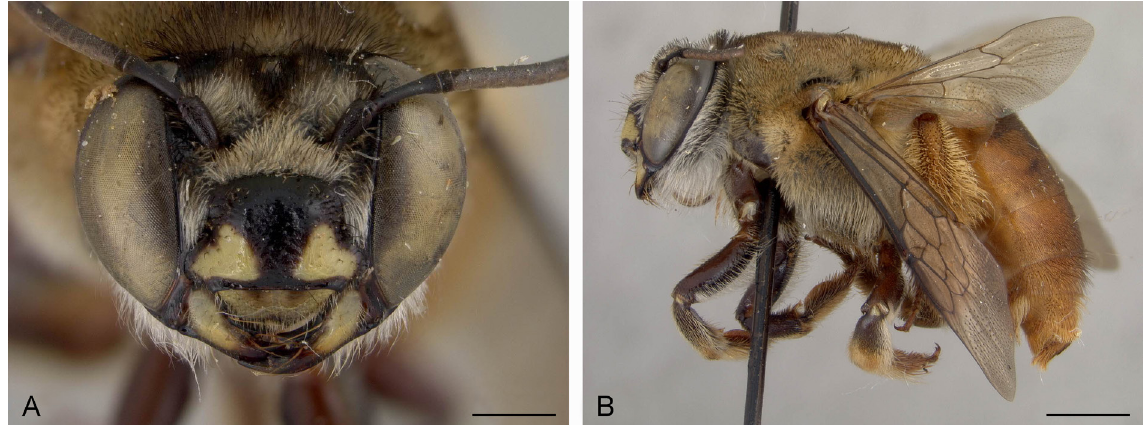
Fig. 17. Hemisia triangulifera Cockerell, 1949, holotype, ♀ (NMNH; USNM ENT 00534217). A . Frontal view. B . Habitus, lateral view. Scale bars: A = 1 mm; B = 2 mm.